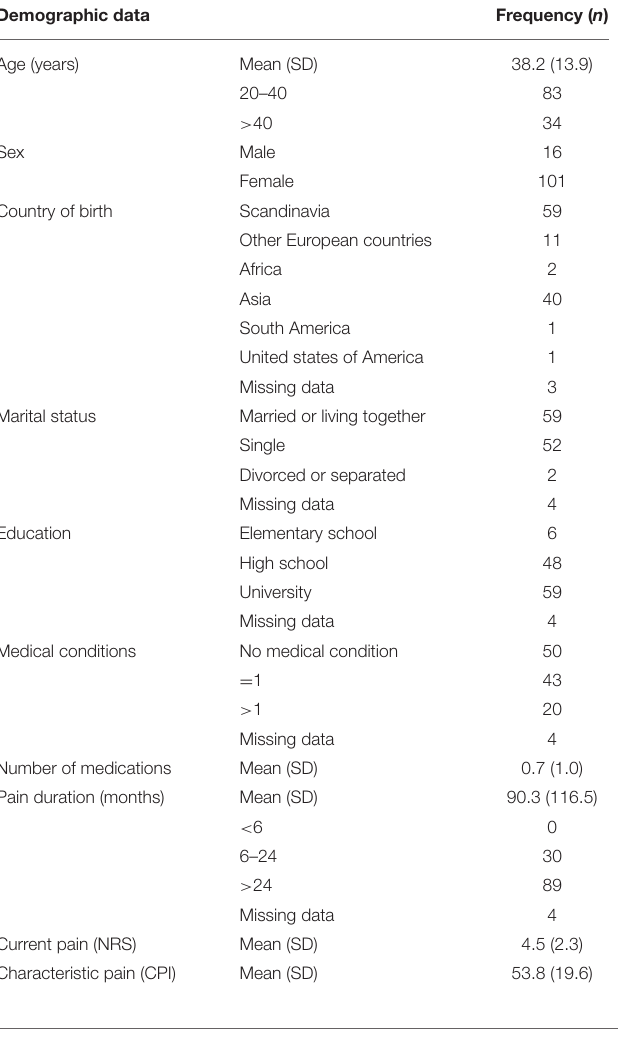
TABLE 1 | Demographic data of 117 patients with TMD myalgia (16 men and 101 women).